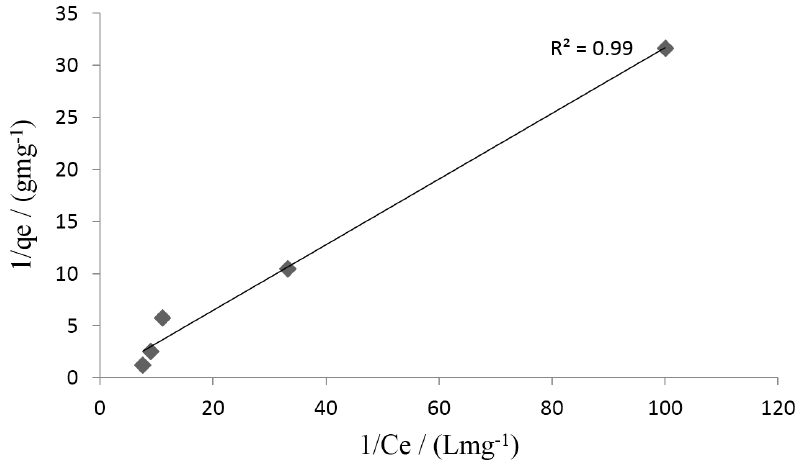
Figure 7. Langmuir plot for Pb 2+ adsorption onto synthesized